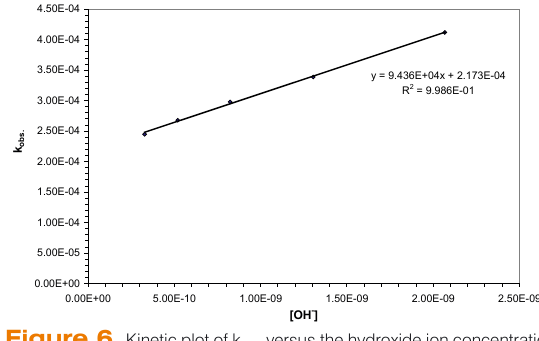
y = 9.436E + 04 x + 2.173 E - 04 R 2 = 9.986E -